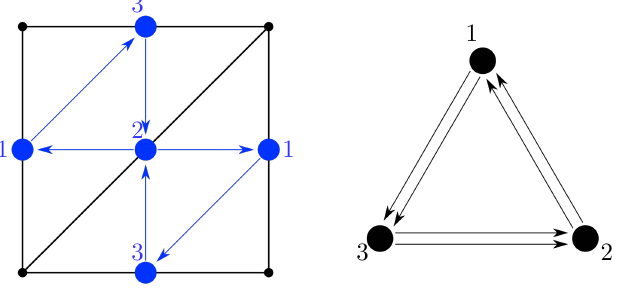
Figure 6 . Triangulation of the once-punctured torus C , where opposite edges are identified, and the resulting Markov quiver for the = 2 ∗ gauge theory. The quiver is obtained by adding a node N to the midpoint of each edge and clockwise oriented arrows on the faces of the